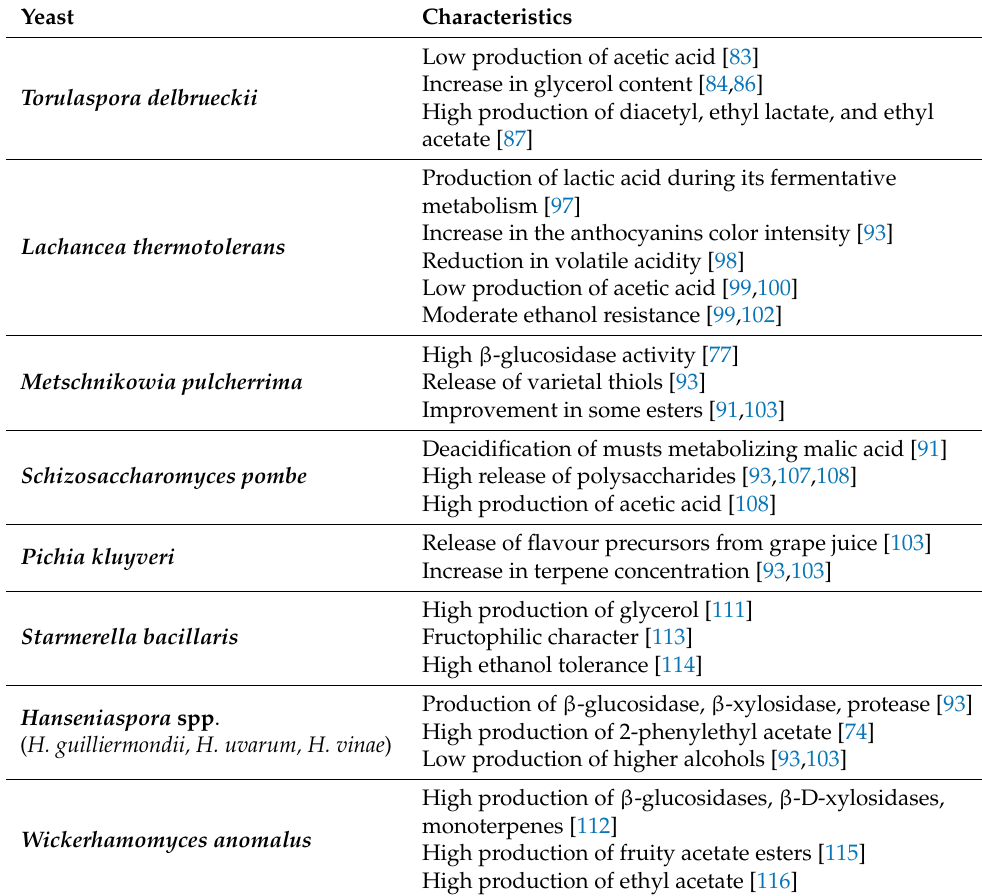
Table 2. Main non- Saccharomyces species of oenological interest and their contribution in aromatic compounds in